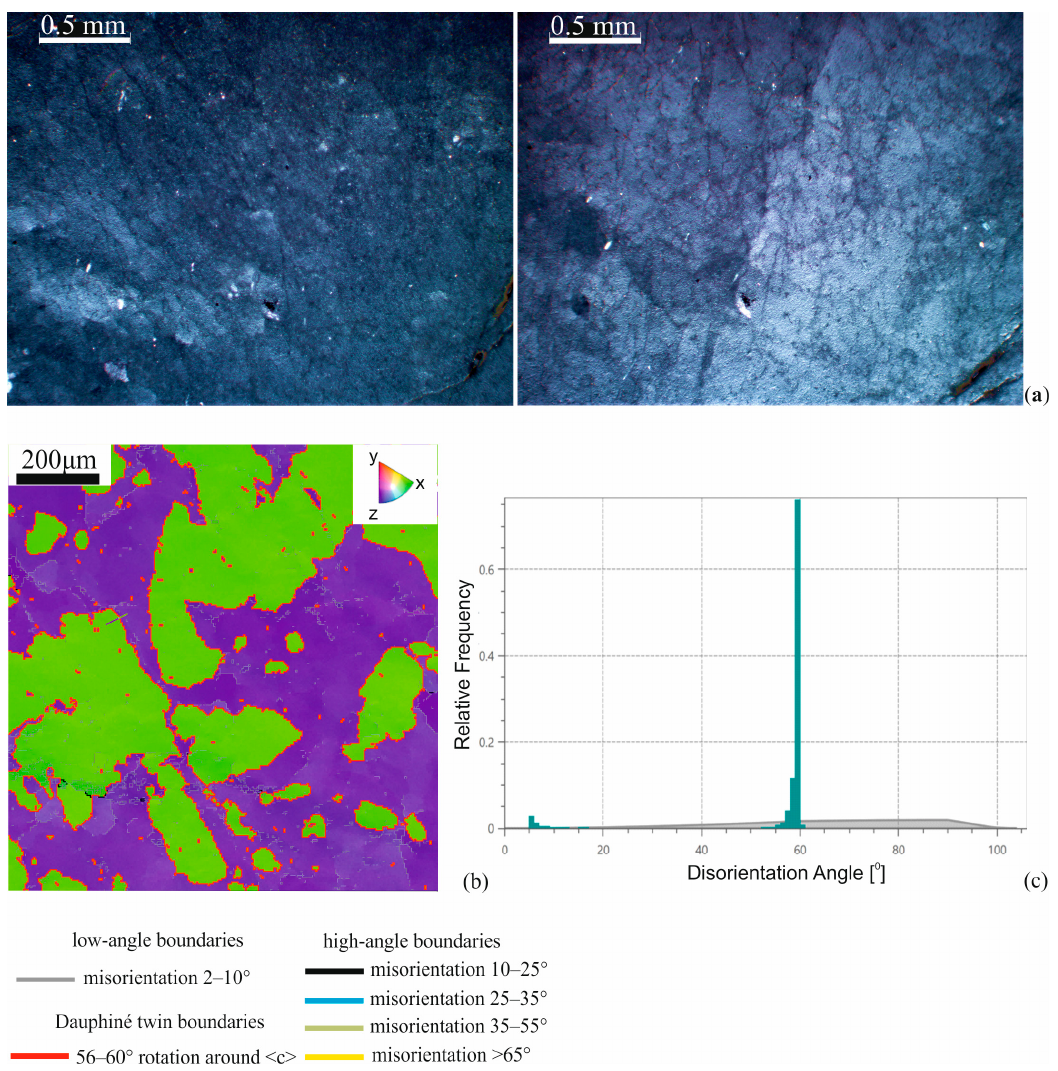
Figure 6. Features of the microstructure of vein quartz type A: ( a ) optical micrography of the quartz with a uniform texture; ( b ) the processed electron back scatter diffraction (EBSD) band contrast (BC) + inverse pole figure (IPF) map — the symbols shown here are color coded for the boundaries to indicate the angle of boundaries' misorientation for use in the next figures; and ( c ) the disorientation angle distribution and theoretical curve (gray color).